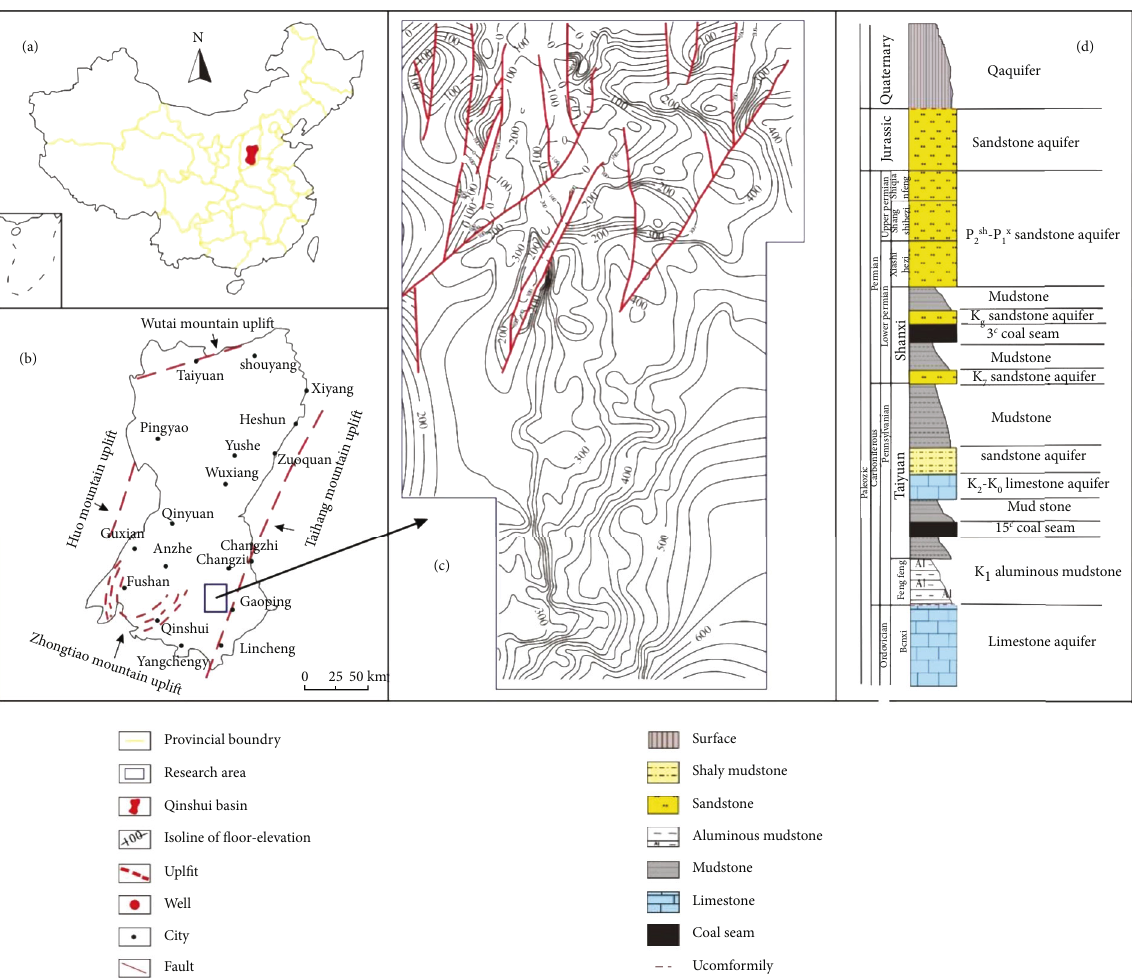
Figure 2: Locations of the study area and wells. (a) Location of the study area in China. (b) Location of the Shizhuang Block in the southern Qinshui Basin. (c) Topography of the study area. (d) Stratigraphic column of the coal-bearing strata